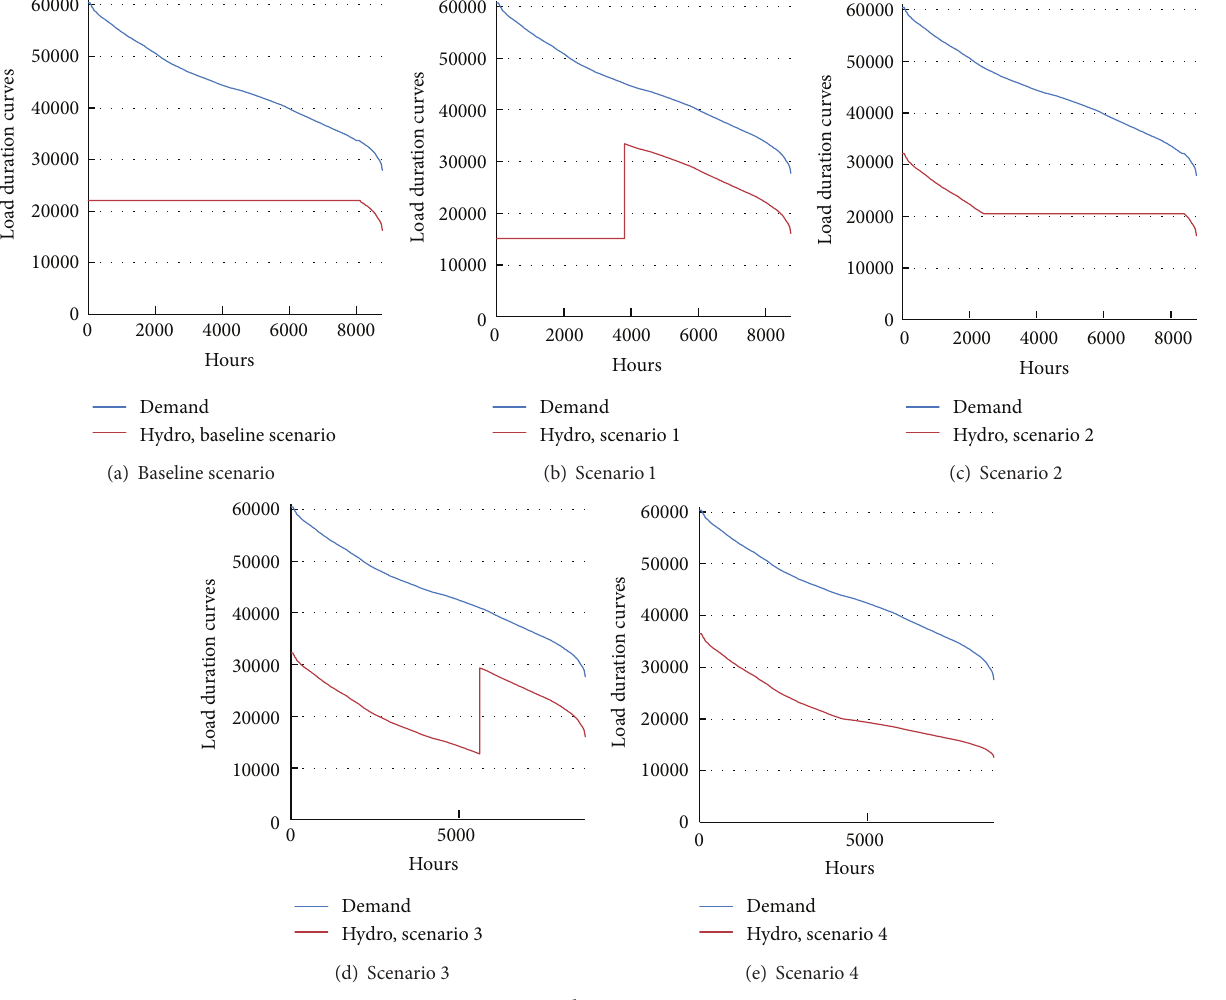
Figure 5: Hydropower